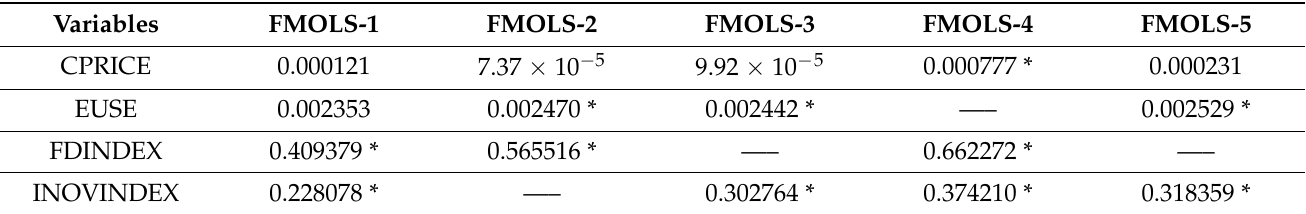
Table 7. Panel FMOLS